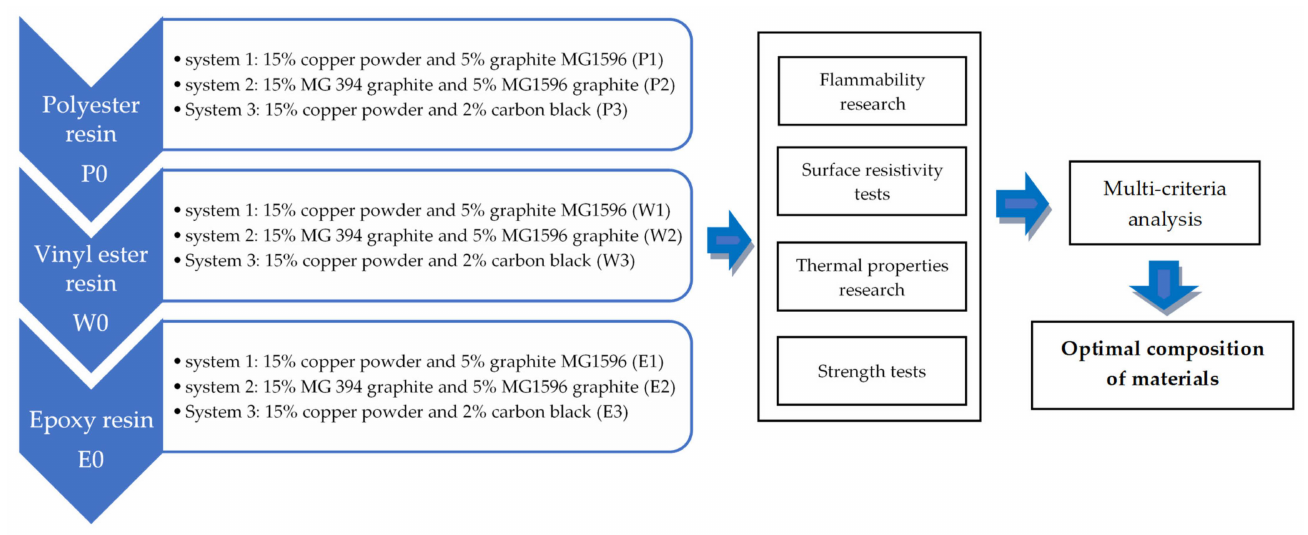
Figure 1. Scheme of the research